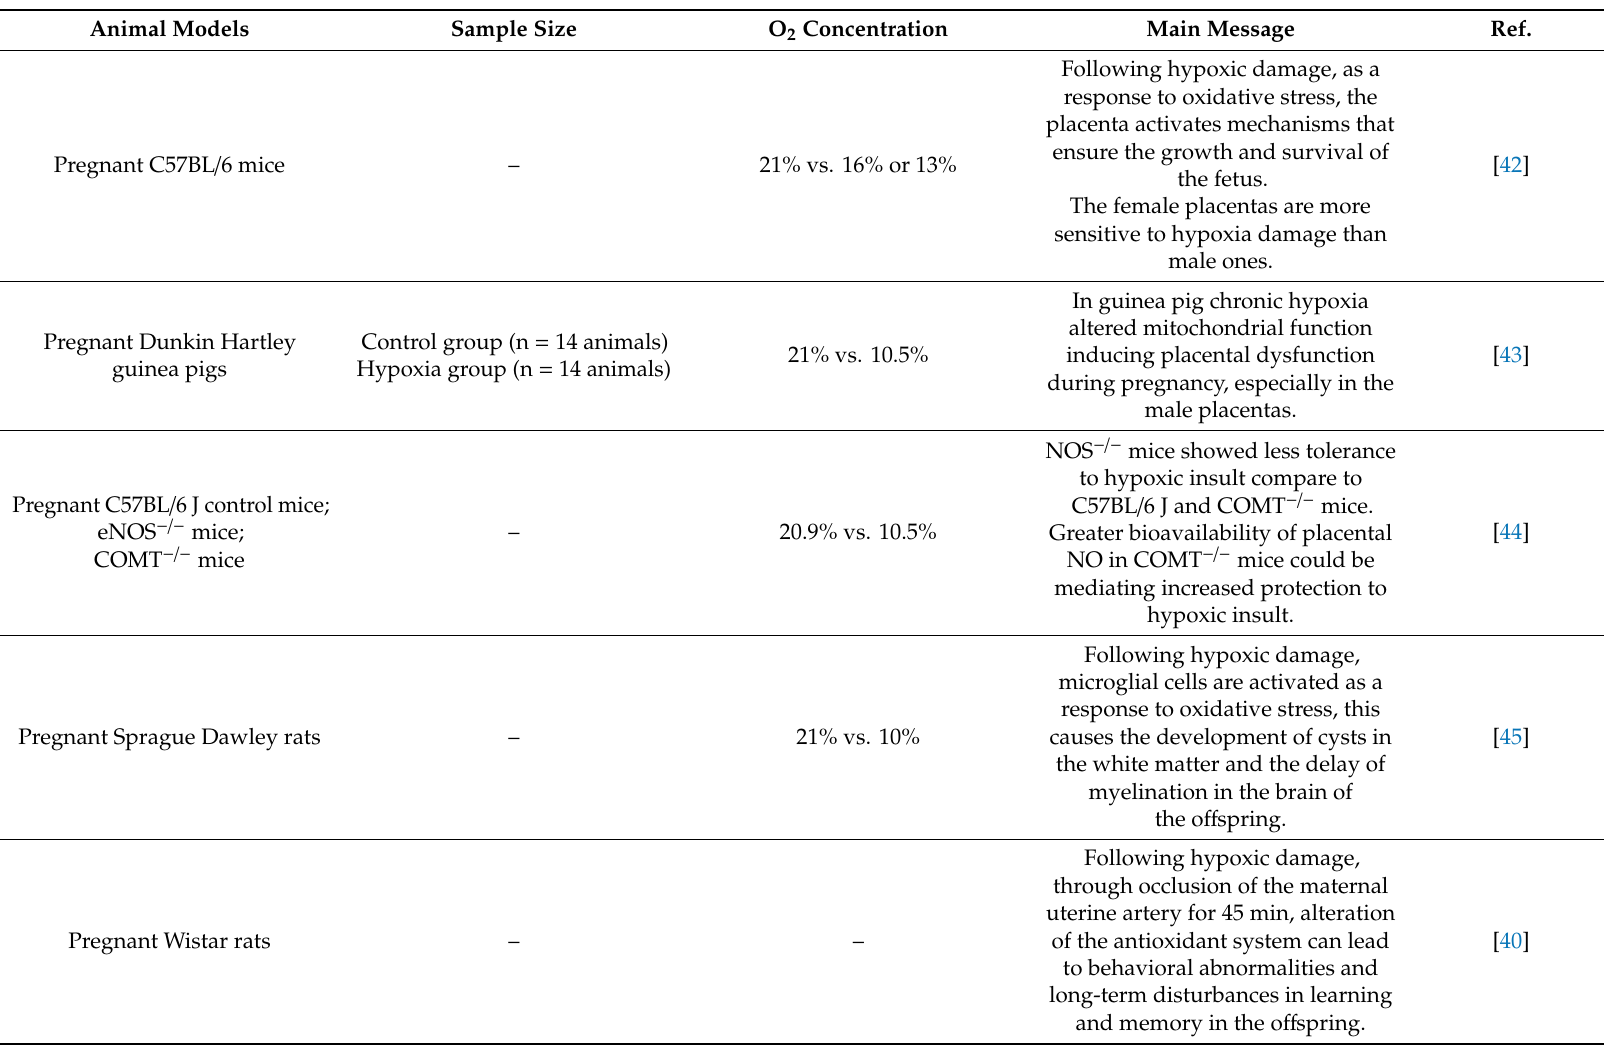
Table 1. Synthesis of the studies that evaluate the role of fetal hypoxia-induced oxidative stress in several animal